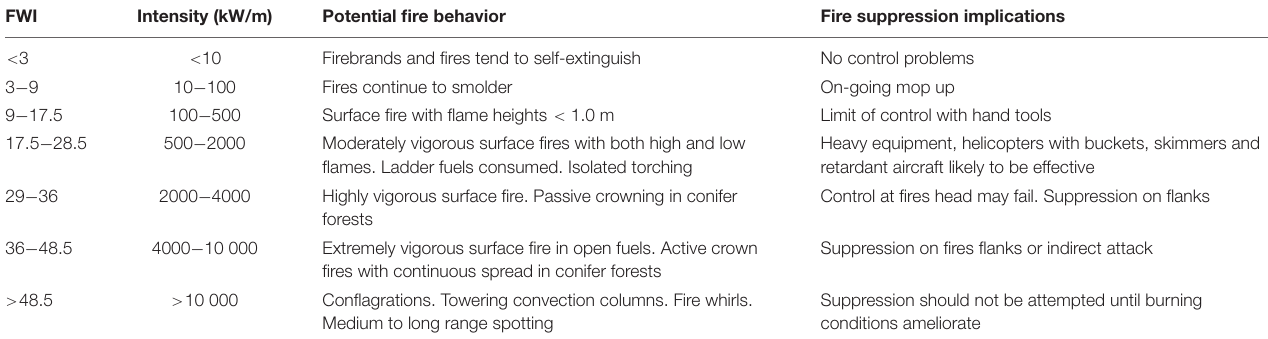
TABLE 2 | Nominal frontal fire intensities, potential fire behavior and suppression implications (after Taylor and Alexander, 2017) for the Van Wagner (1987) FWI – Intensity scaling function. FWI Intensity